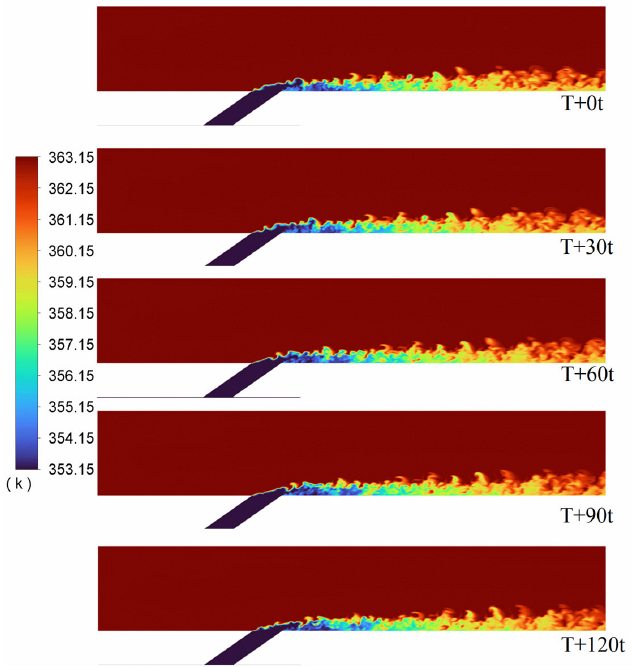
Figure 11. Instantaneous temperature distribution at different times on the central section of Case 1.